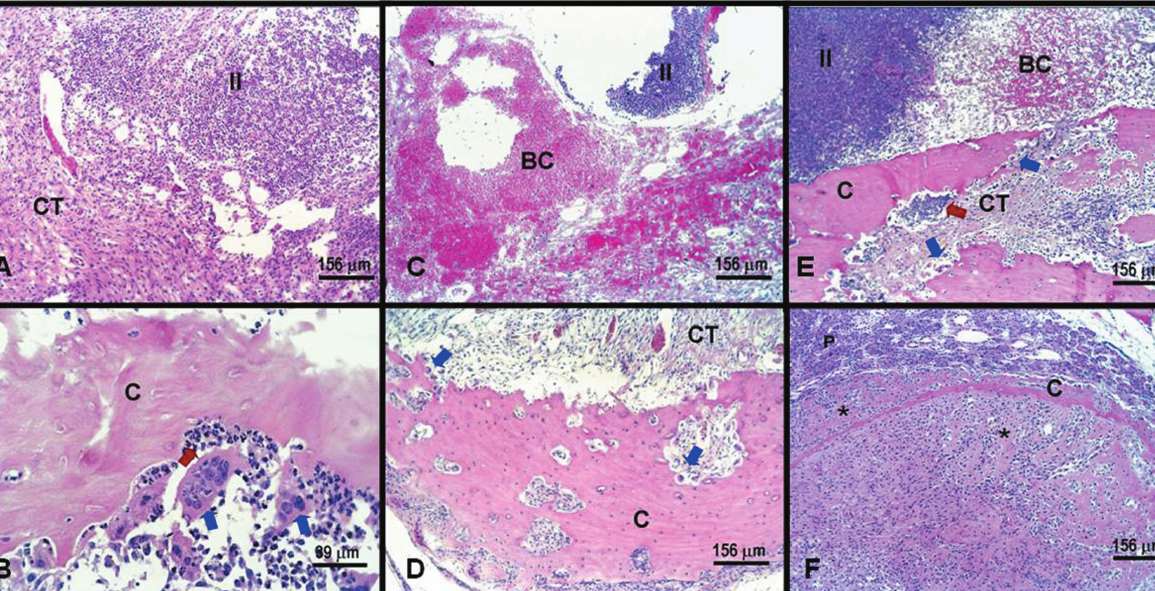
Table 2- Correlation analysis among the histometric parameters throughout the alveolar healing in non-infected and infected rat sockets